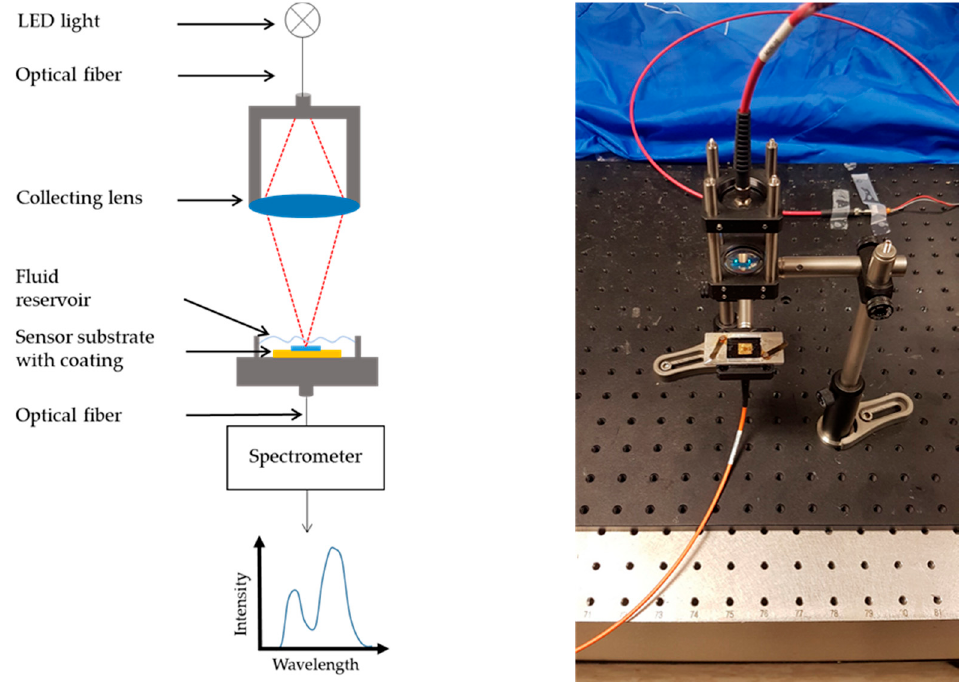
Figure 2. Schematic representation and picture of the sensor setup to record the transmittance spectra of the sensor substrates.